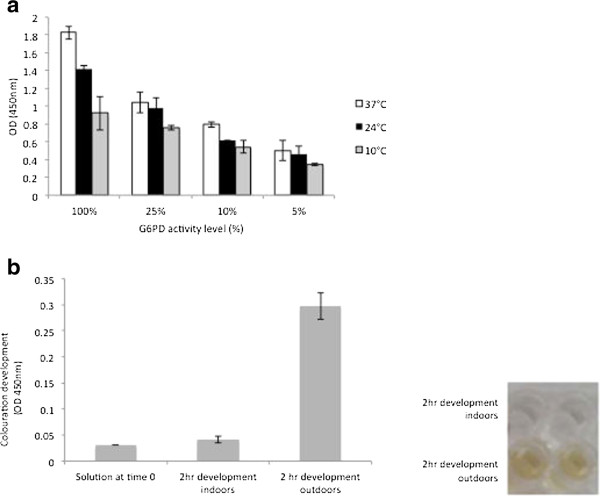
Assay kinetics at various temperature and light levels. a) G6PD activity measured after 2 hr development at 37°C, 24°C, and 10°C. Classification of G6PD values was possible at all temperatures, with 10°C showing the least variation Results repeated 3× in duplicate (p > 0.05). b) Colouration development in reagents only, following 2 hr incubation outdoors (exposure to sunlight), and indoors (exposure to scattered light). Aberrant colouration measured at the same wavelength as the G6PD assay (OD 450 nm) was detected.